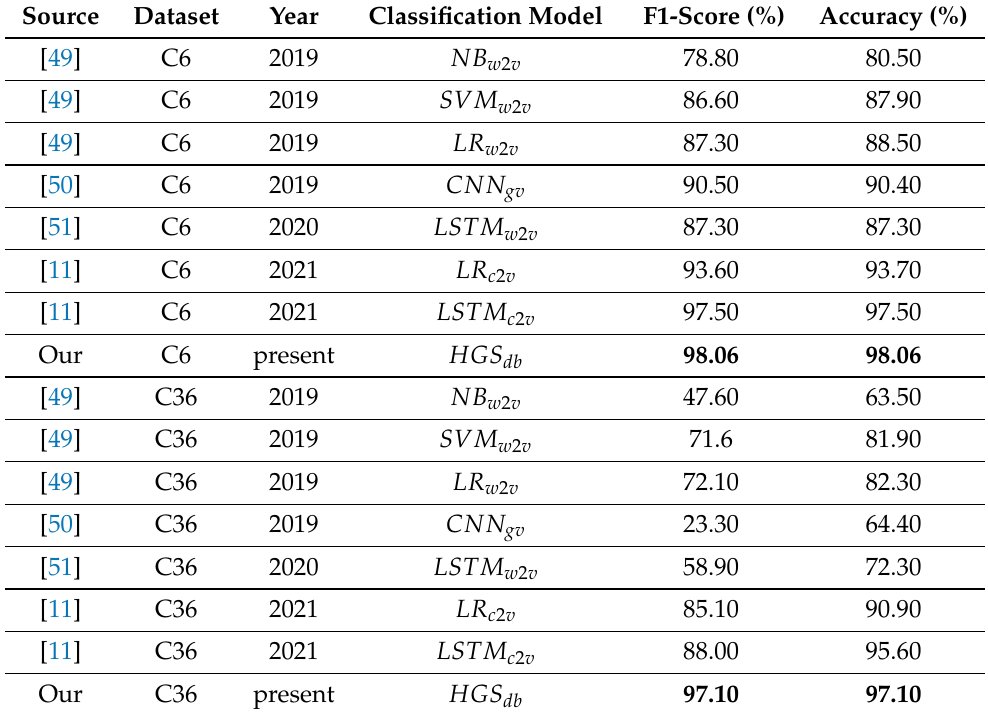
Table 7. Comparison results of the existing